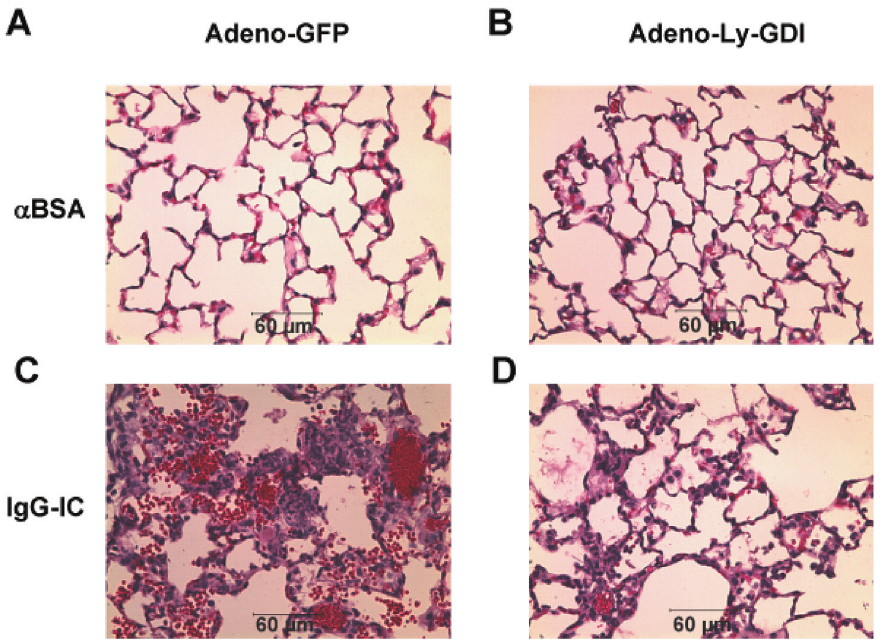
Fig 3. Histologically, Ly-GDI expression attenuates IgG immune complex-induced acute lung inflammation. Adeno-GFP or Adeno-Ly-GDI was injected to mice via an airway instillation at a dose of 5 × 10 8 PFU. 3 days later, the mice were subjected to IgG immune complex-induced lung injury or control treatment ( α BSA only). Lungs were harvested 4 h later, and lung sections were stained with H & E (40 × magnification). Lung sections shown included: Adno-GFP + anti-BSA (A), Adeno-GFP + IgG IC (B), Adeno-Ly-GDI + anti-BSA (C), and Adeno-Ly-GDI + IgG IC (D). Scale bar, 60 μ m.